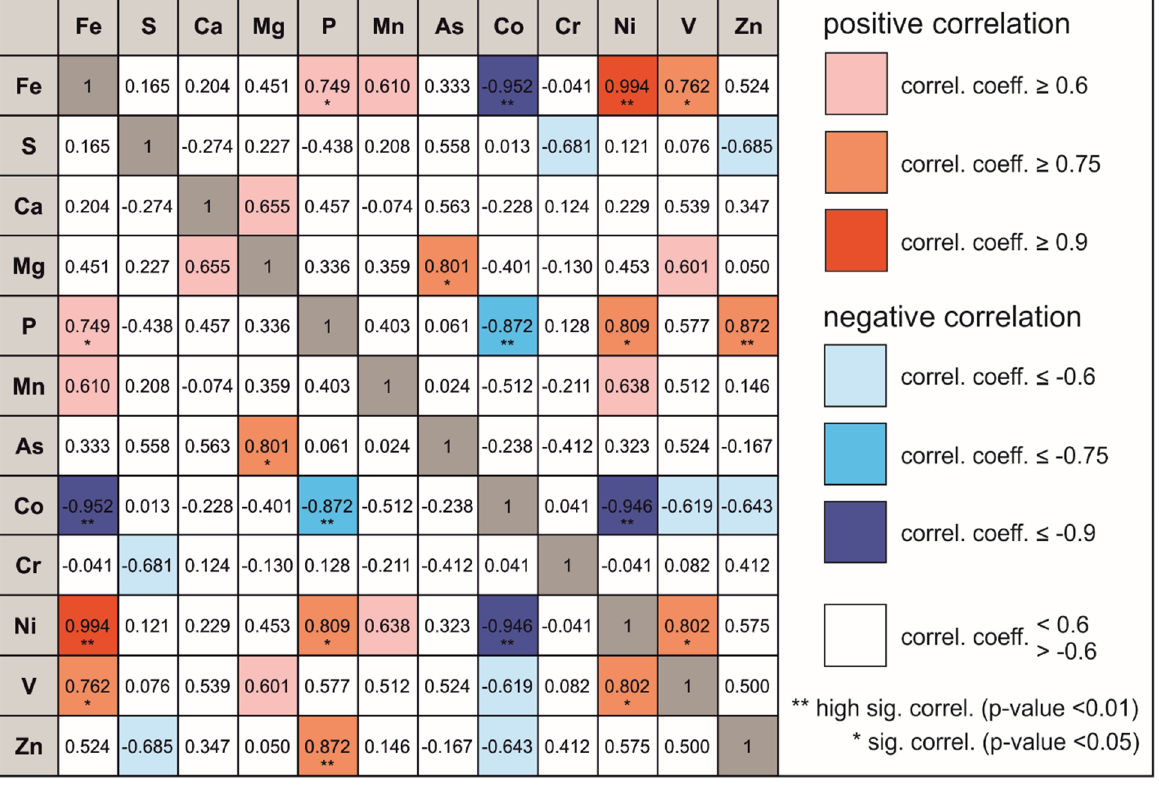
Figure 7. A Spearman element correlation matrix for 8 samples of the Haltern Fm.